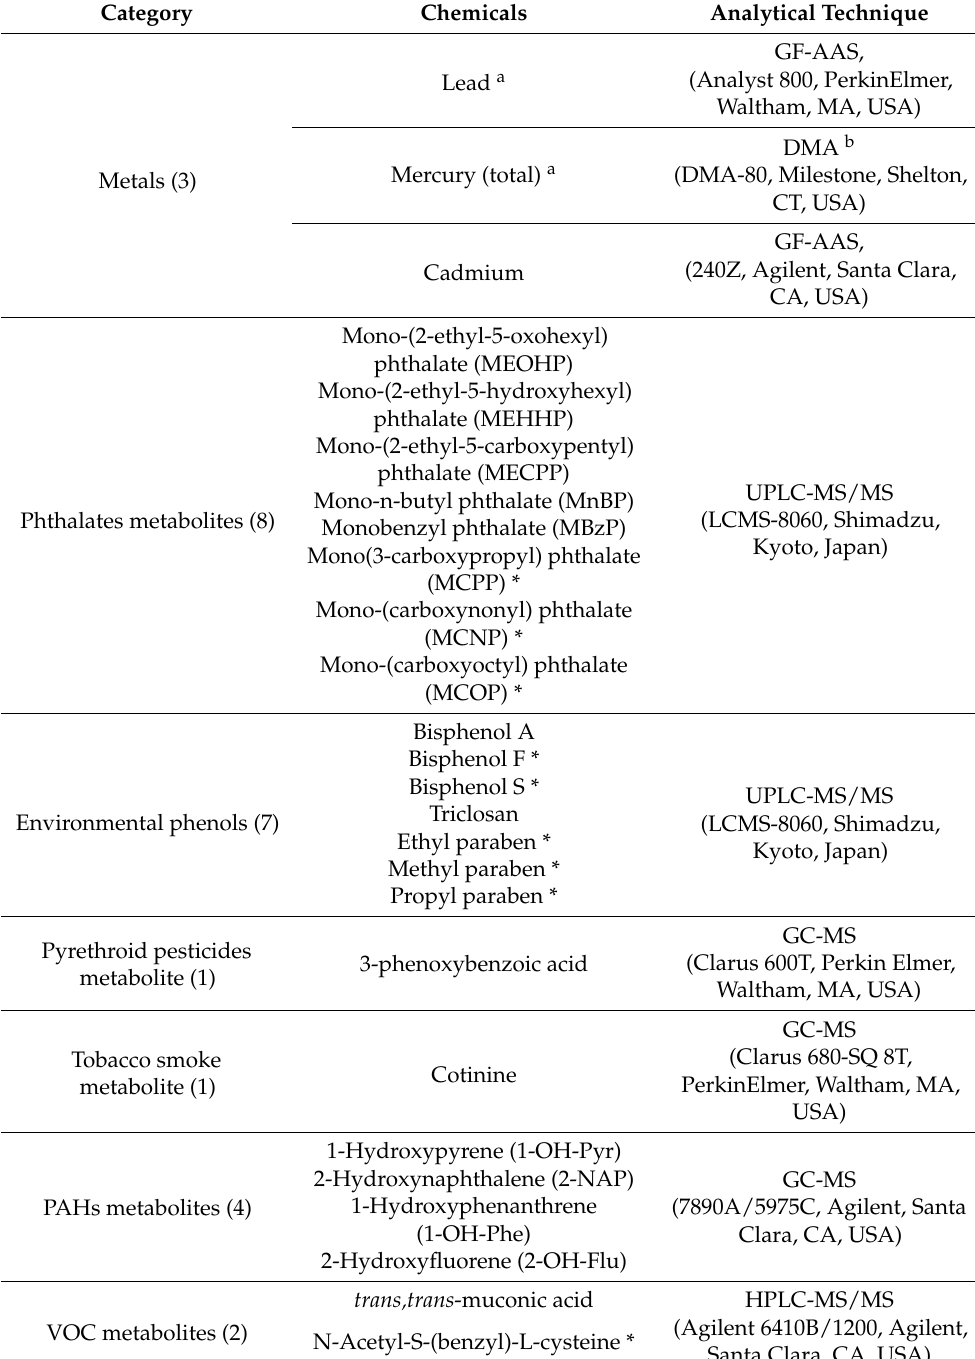
Table 2. Target chemicals of urinary analyses measured in KoNEHS Cycle 3